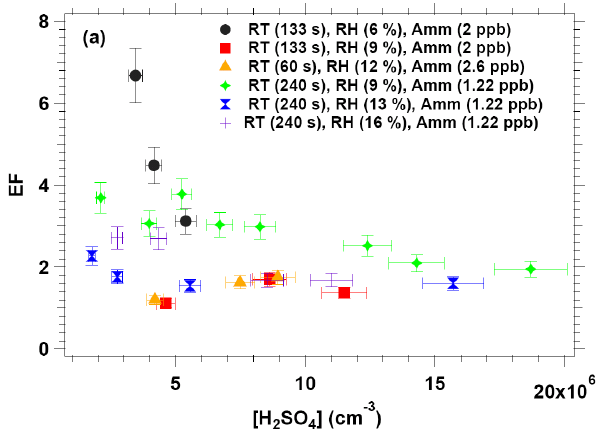
660 Figure 5b. The measured EF as a function of RH. [H 2 SO 4 ] = 5×10 6 – 7×10 6 cm -3 . [NH 3 ] = 20 661 Fig. 5b. The measured EF as a function of RH. [H 2 SO 4 ]=5 × ppbv. RH = 7 – 39%. Residence time = 80 – 240 s. 662 10 6 –7 × 10 6 cm − 3 . [NH 3 ]=20ppbv. RH=7–39%. Residence time=80–240s. 663